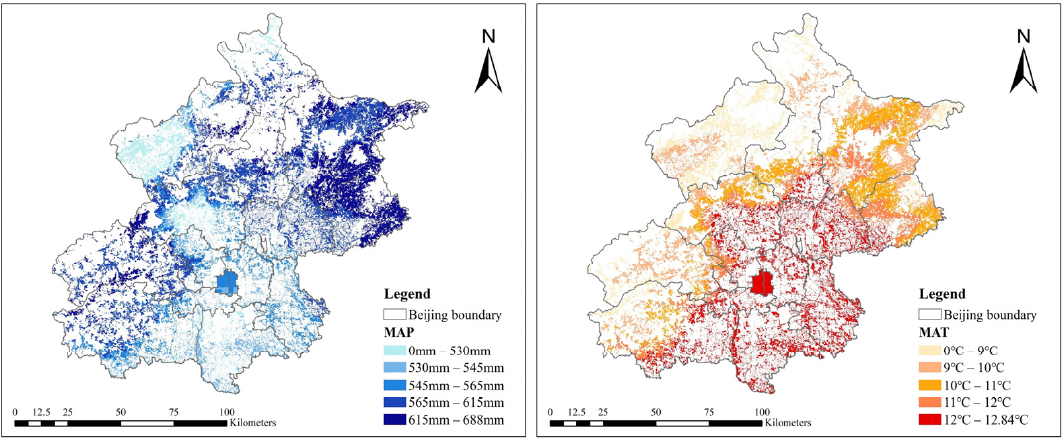
Figure 7. MAP and MAT distribution.